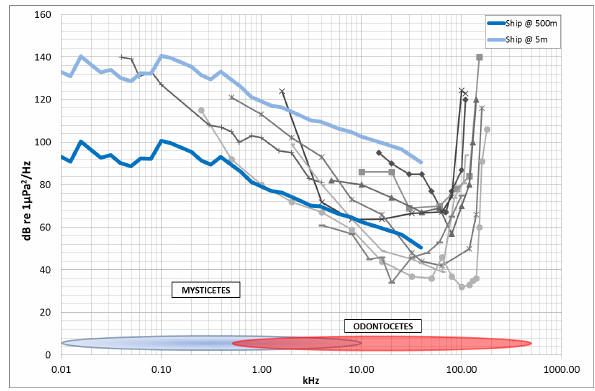
Figure 1: Odontocetes audiograms together with typical ship spec- tra at different distances and communication ranges of odontocetes and mysticetes